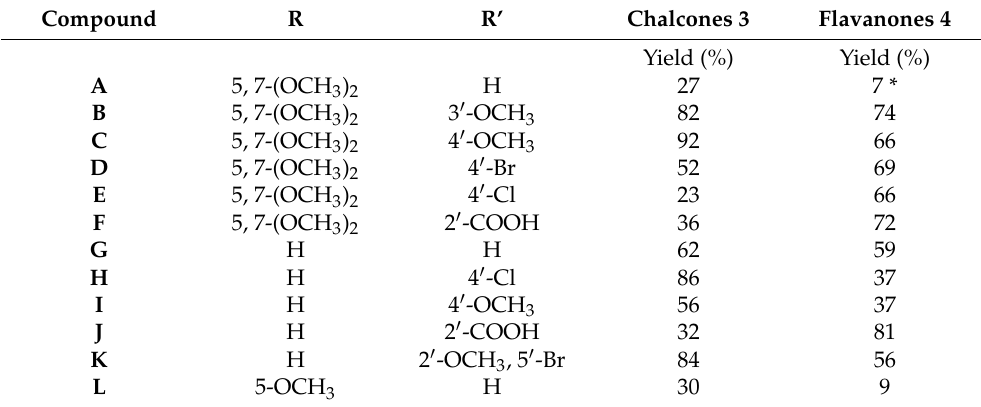
Table 1. Synthesis of chalcones 3A – 3L and flavanone derivatives 4A – 4L